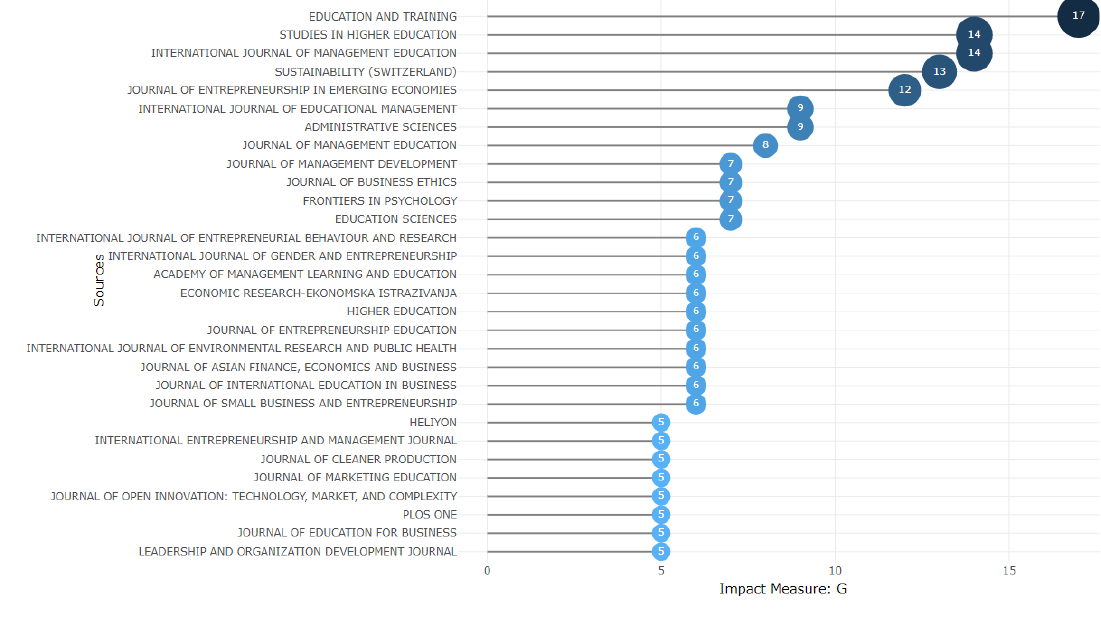
Figure 4. Source Local Impact According to the Ginny